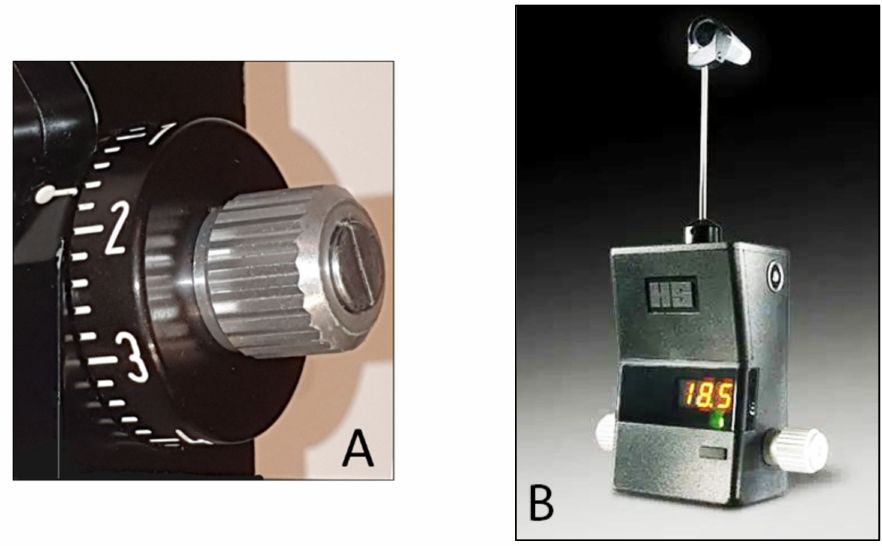
Figure 3. ( A ) Scale with IOP values in the Goldmann tonometer; ( B ) digital Goldmann tonometer (posterior